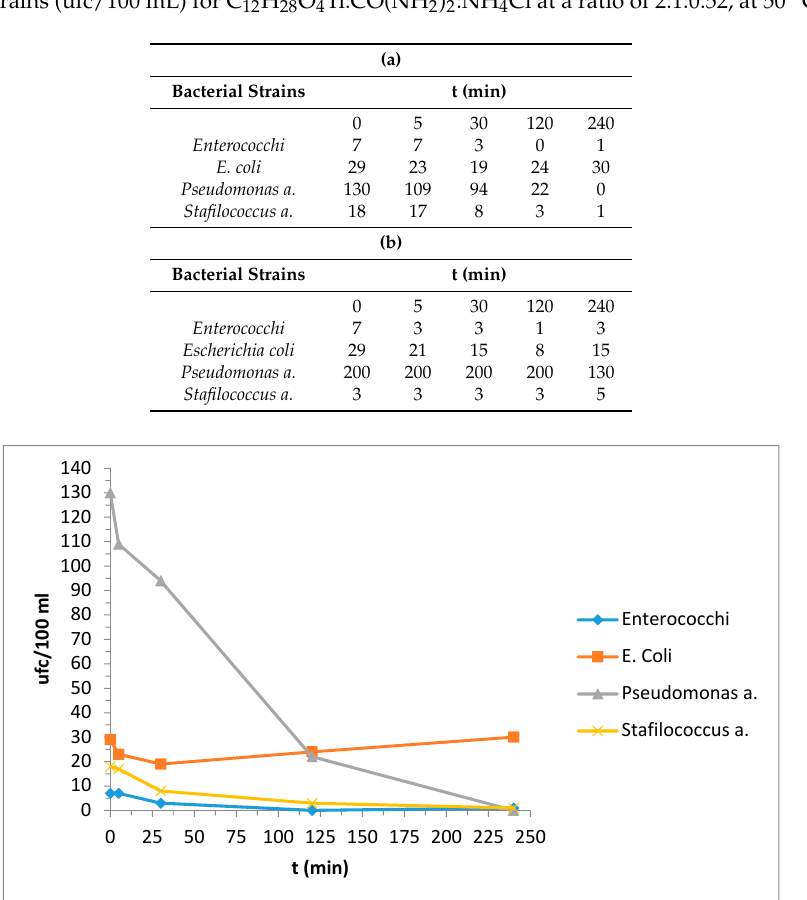
Table 10. ( a ) Bacterial strains (ufc/100 mL) for C 12 H 28 O 4 Ti:CO(NH 2 ) 2 at a ratio of 2:1, at 50 ◦ C; ( b )